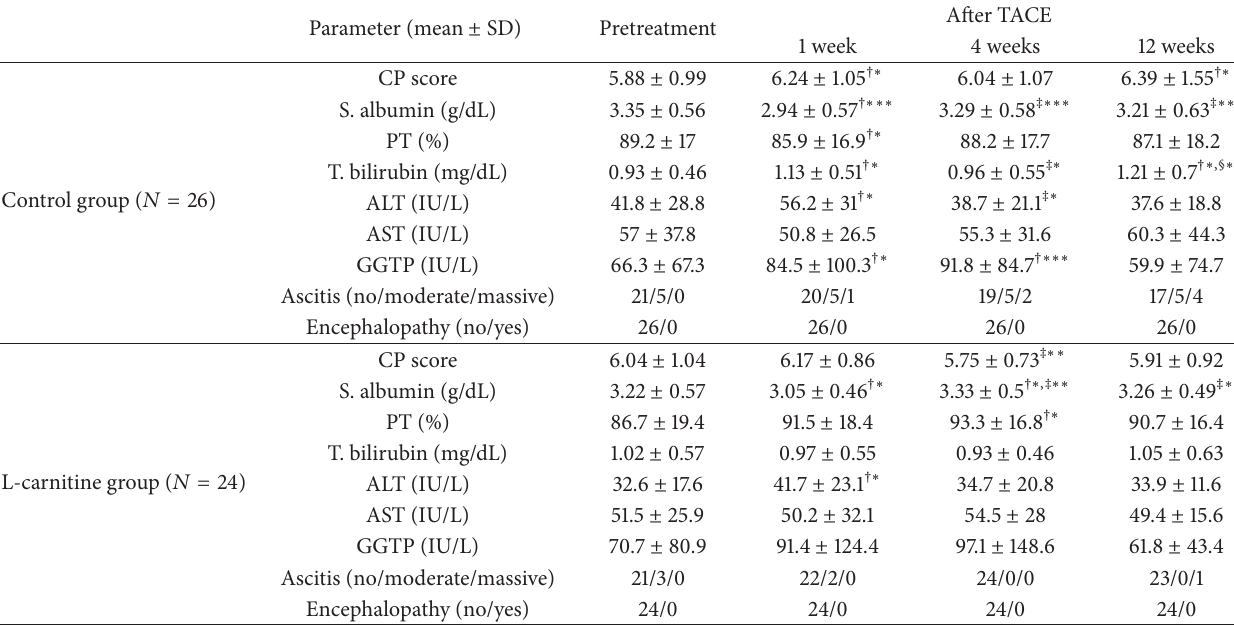
Table 2: Effects of L-carnitine in overall study patients.